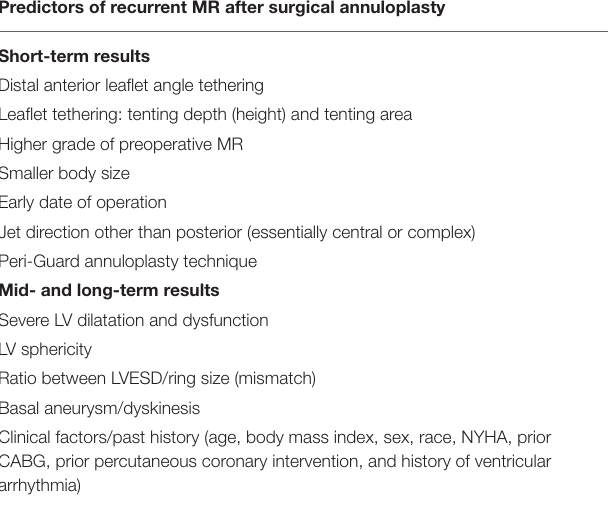
TABLE 2 | Predictors of failure of annuloplasty evaluated in surgical setting. Predictors of recurrent MR after surgical